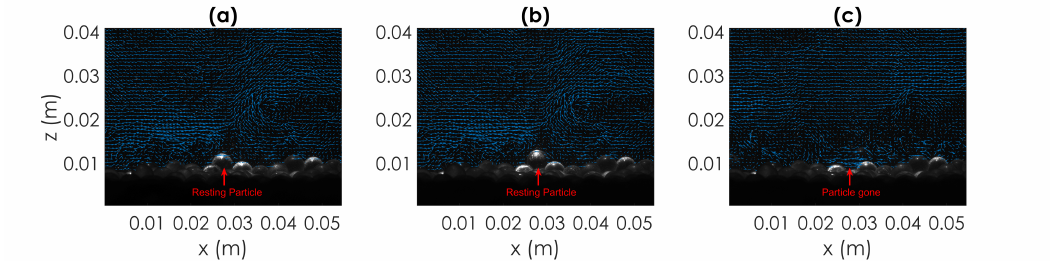
Figure 11. Particle entrained because of hydrodynamic forces (Type A; particle 12, Test T1). Sequence of three PIV images respectively showing (from ( a – c )): at time t = t 0 (2 time instants, corresponding to 0.1333 s, before entrainment) the bright particle located in the centre of the image is at rest in the bed; at time t = t 0 + ∆ t (1 time instant, corresponding to 0.067 s, before entrainment) the particle is still at rest in the bed; at time t = t 0 + 2 ∆ t the particle has already left the bed and is rolling. (For clarity only 1 out of 2 vectors are